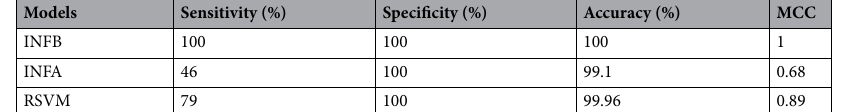
Models Sensitivity (%) Specificity (%) Accuracy (%) MCC